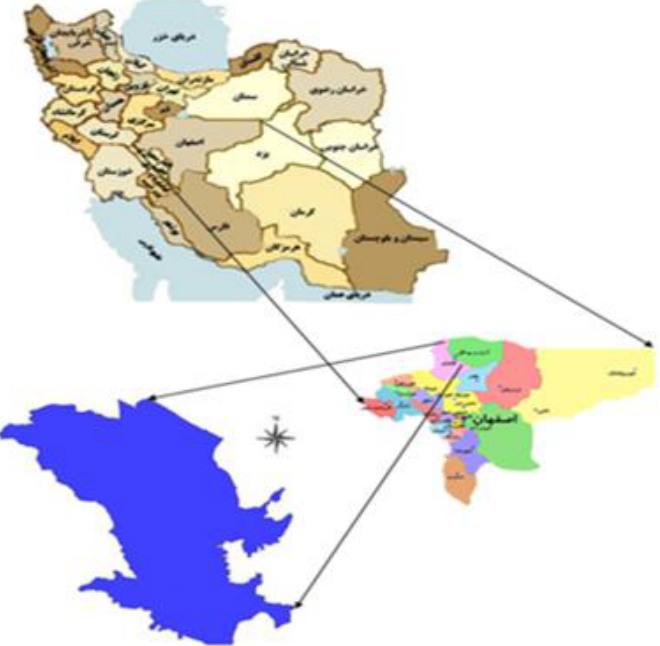
Figure 1. Location of the study area in Iran and Esfahan province